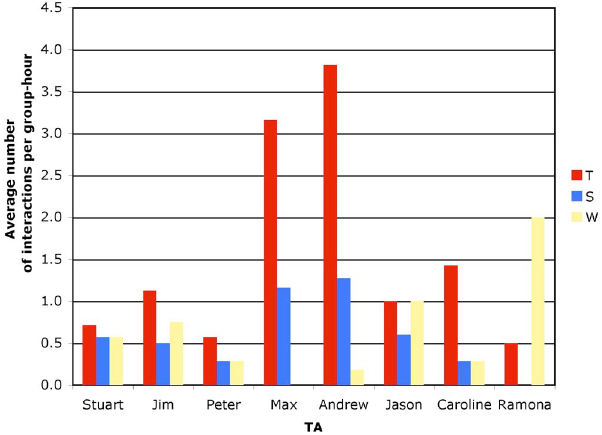
FIG. 3. (cid:1) Color (cid:2) Average number of interactions of each type that each TA experienced per “group-hour” of tutorial. (cid:1) “Group-hours” is the total number of hours that a TA spent with the groups observed.